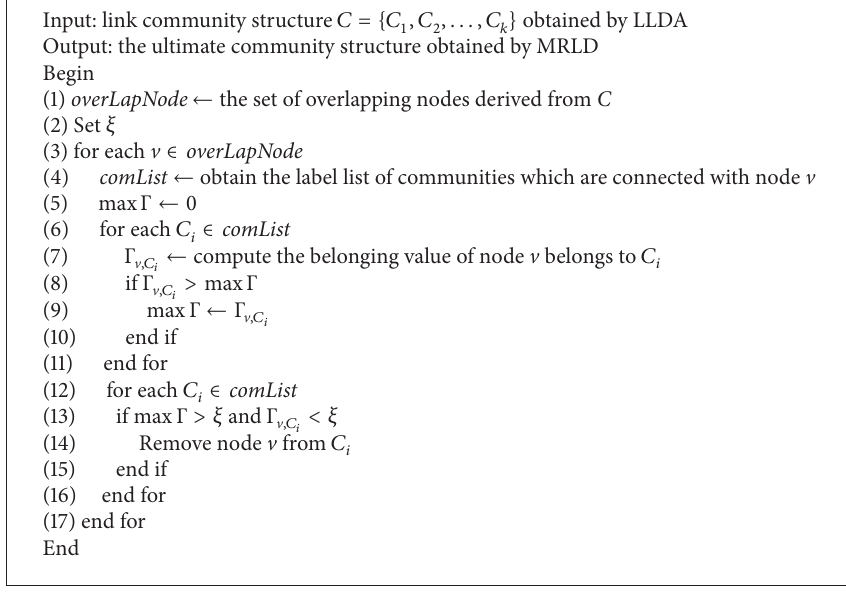
Algorithm 2: Overlapping nodes belonging analysis (ONBA).